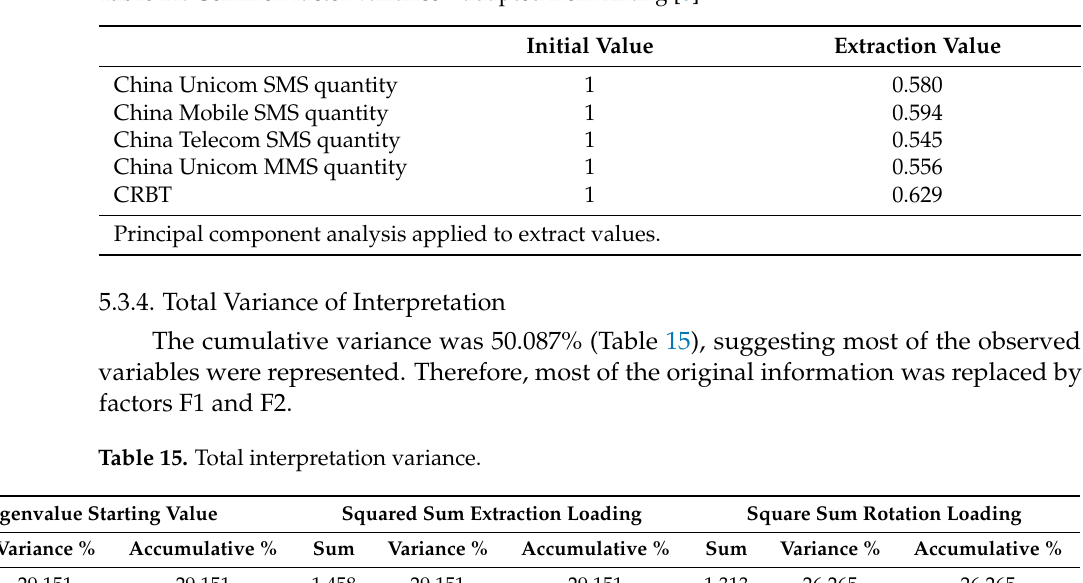
Table 16. Component score coefficient